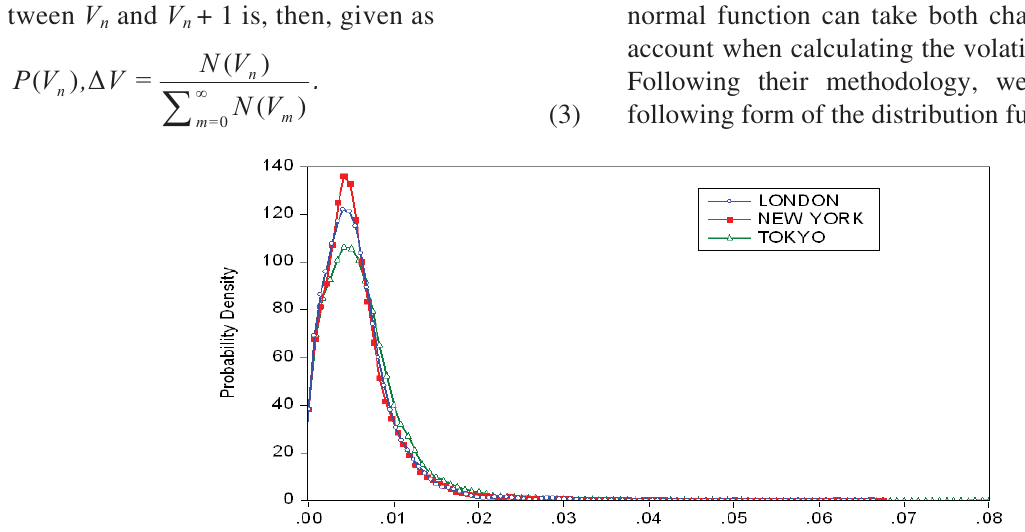
Fig. 3. Probability distributions of gold volatility in London, New York and